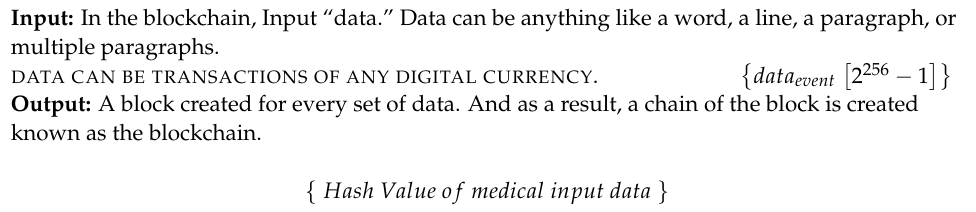
Algorithm 1 Proposed